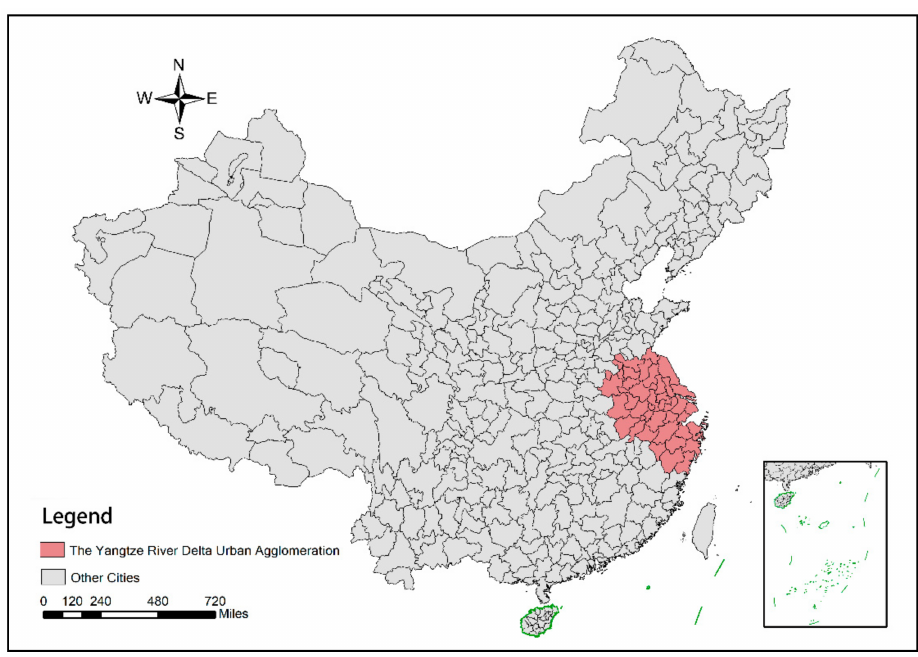
Figure 2. Schematic diagram of the spatial distribution of the Yangtze River Delta urban